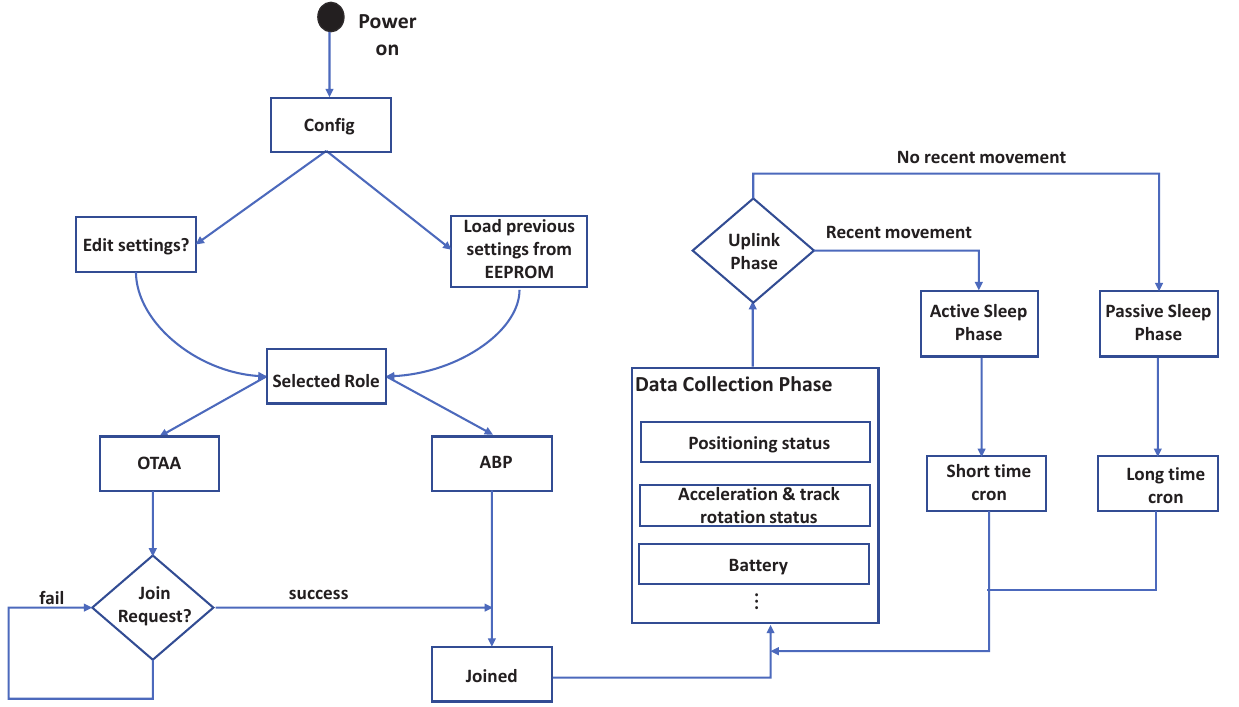
Figure 4. State machine diagram of the